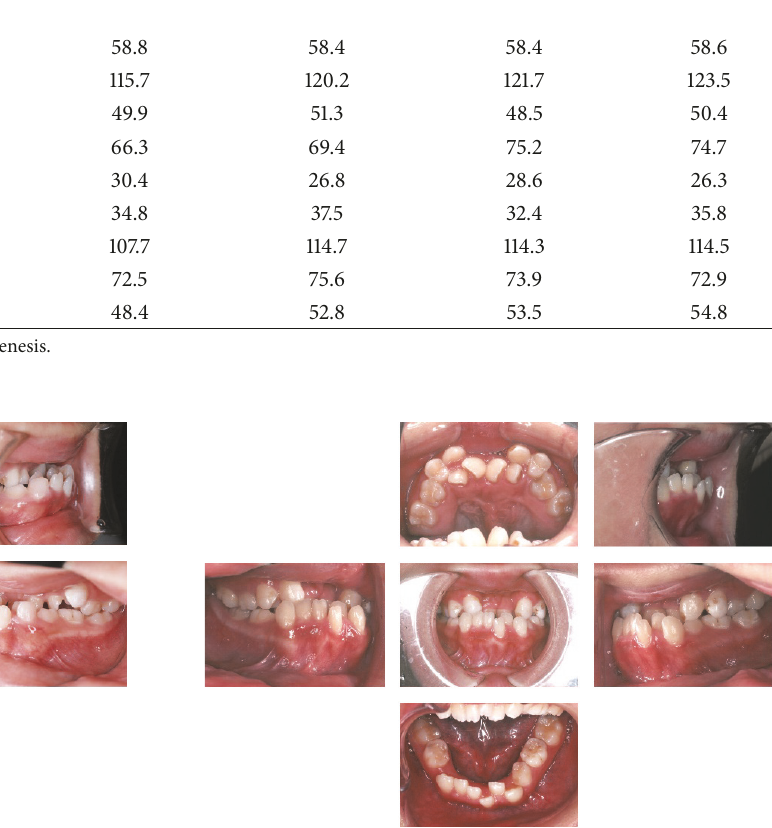
Figure 2: Intraoral photographs before the facemask treatment (9 years and 4 months).